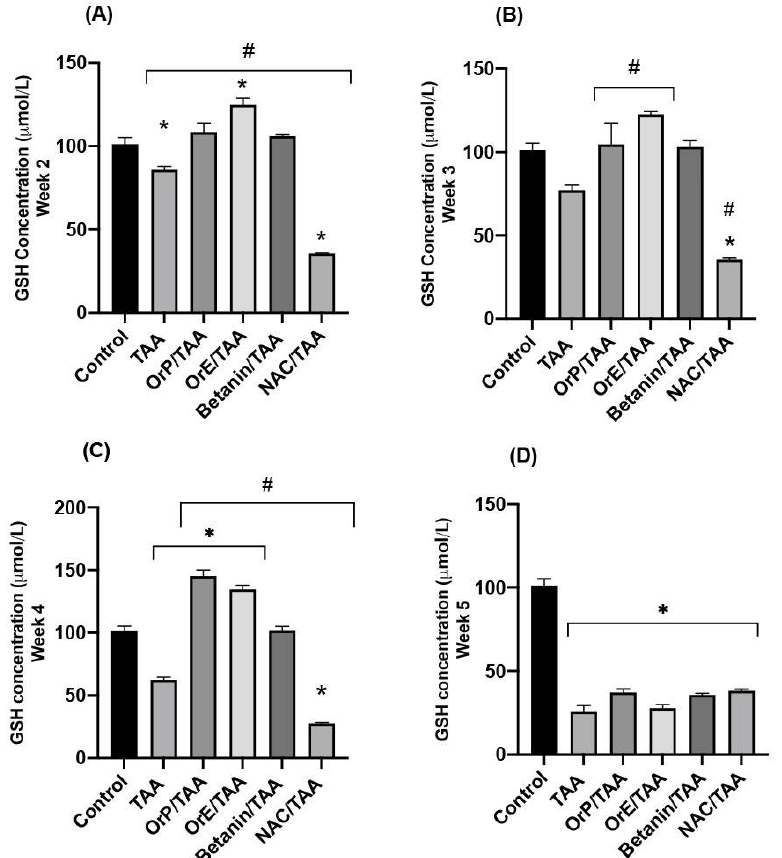
Figure 5. Concentrations of reduced glutathione (GSH) in liver tissue for the different treatments at different evaluation times. ( A – C ) OrP and OrE help to restore GSH levels. ( D ) A significant depletion of GSH is generated, the oxidative damage is severe in chronic treatment and hepatoprotectors have no effect at this point. One-way ANOVA with Tukey’s post hoc test. * p < 0.05 compared to control group, # p < 0.05 compared to TAA group.